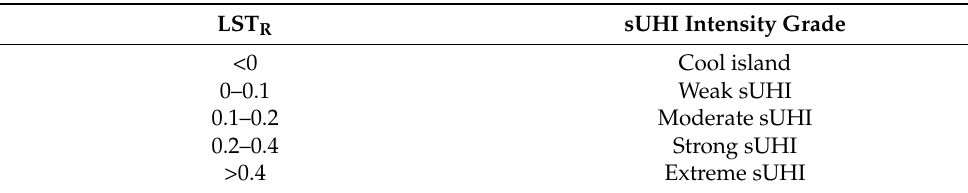
Table 4. sUHI intensity grade